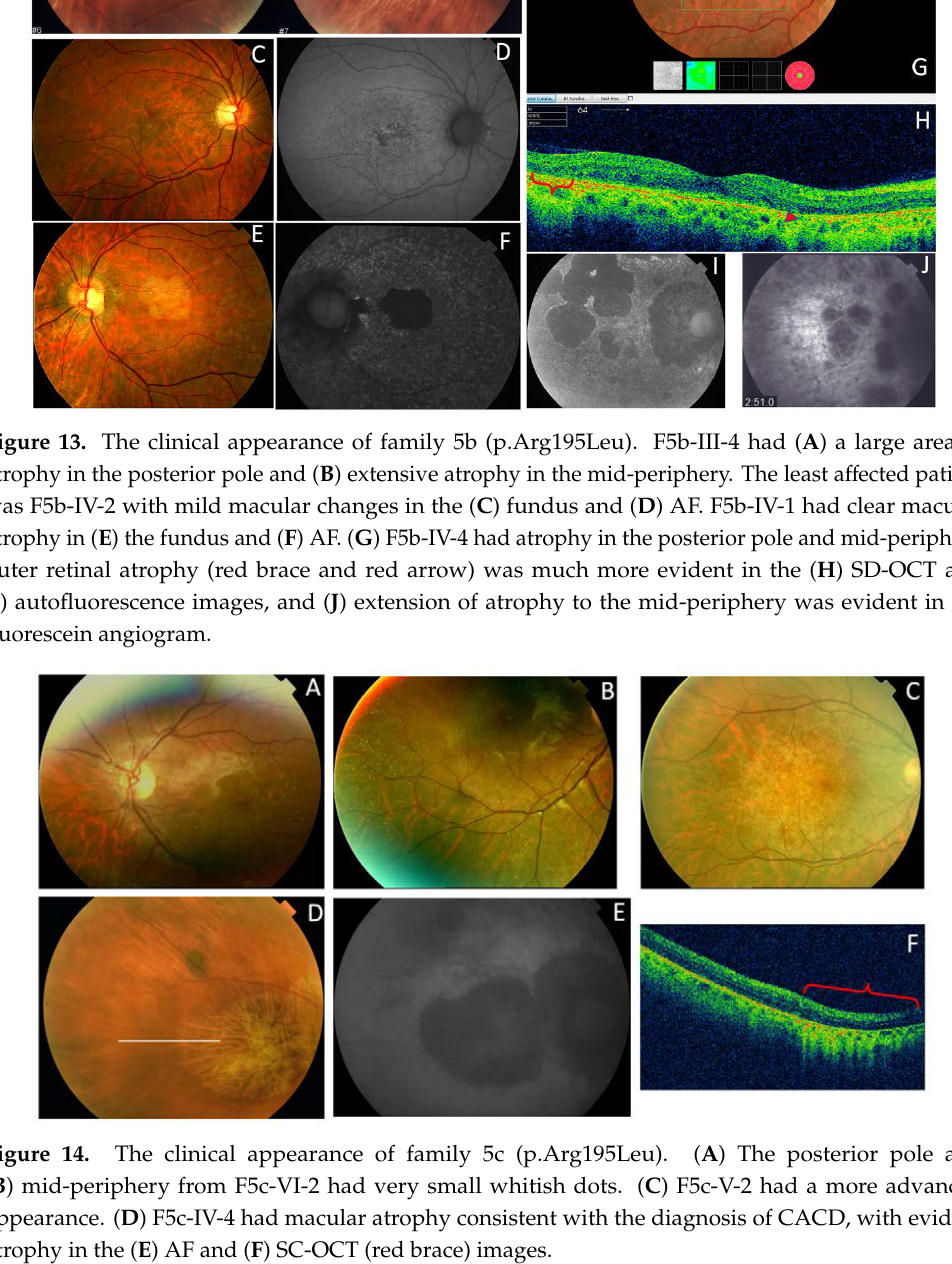
Figure 15. The family 6 pedigree. F7-III-1, a member of a large family with ADRP, was first examined by us at age 48 years (Figure 16). She presented with pigmented spicules in the retinal periphery and concentric VF retraction (Figure 17). The scotopic and photopic ffERG were abolished (Figure 7).